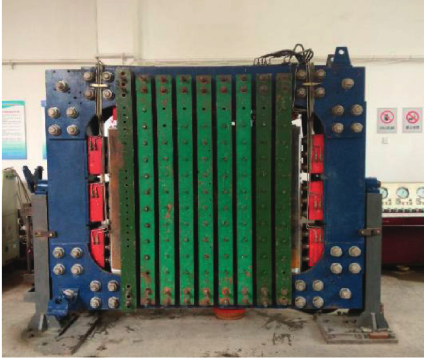
Figure 1: Multifunctional testing machine for rock and soil.